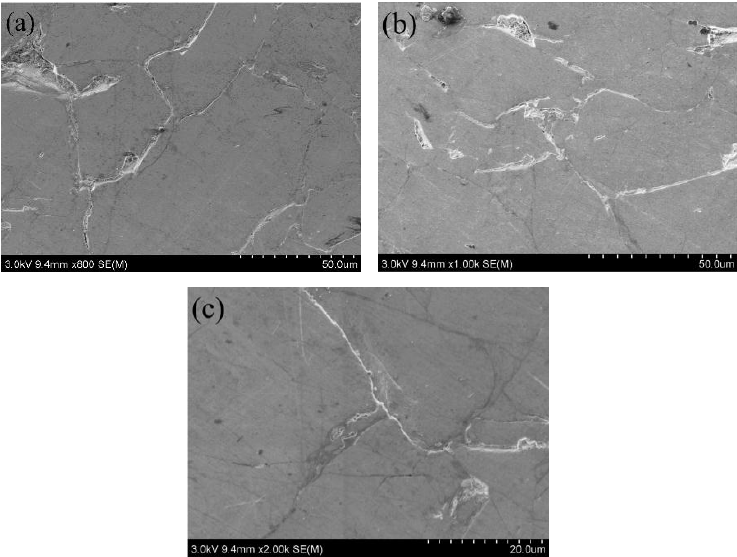
Figure 7. SEM images of the cross-section of a sample: ( a ) 800 × magnification, ( b ) 1000 × magnification, ( c ) 2000 × magnification.